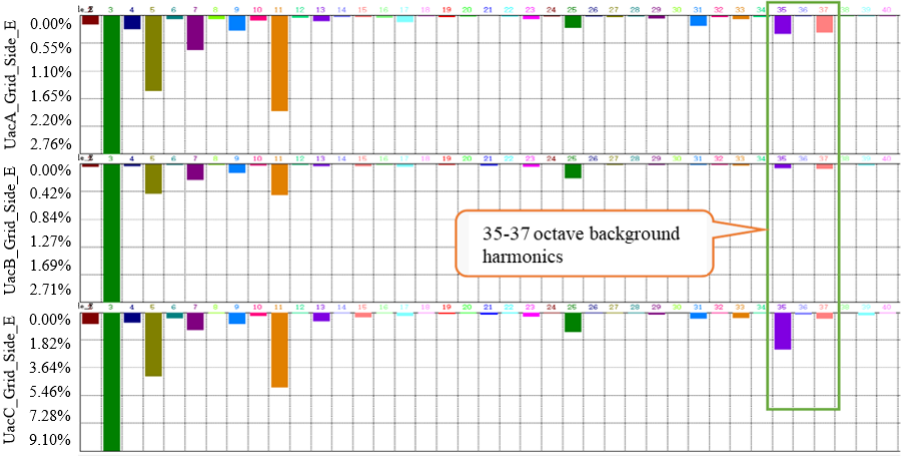
Figure 9. Background harmonic spectrum analysis.